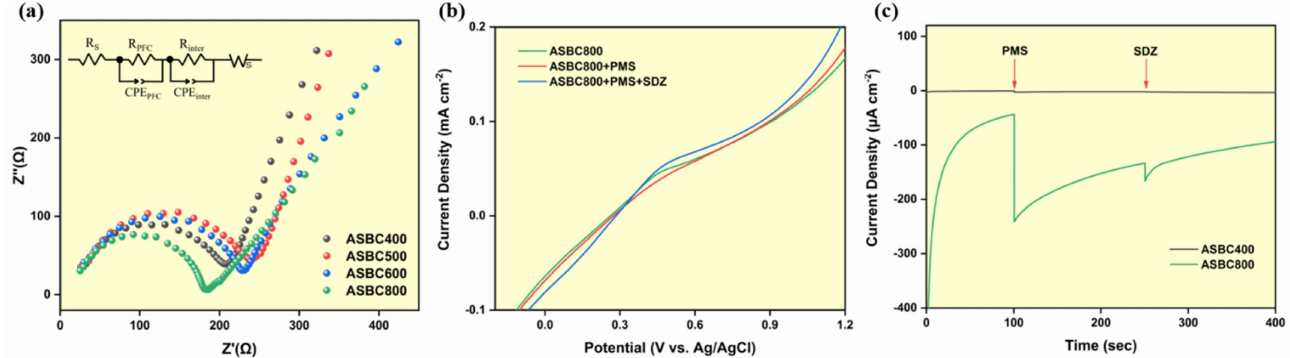
Figure 9. EIS analysis of ASBC800 ( a ), LSV under different conditions ( b ), and I-t curves ( c